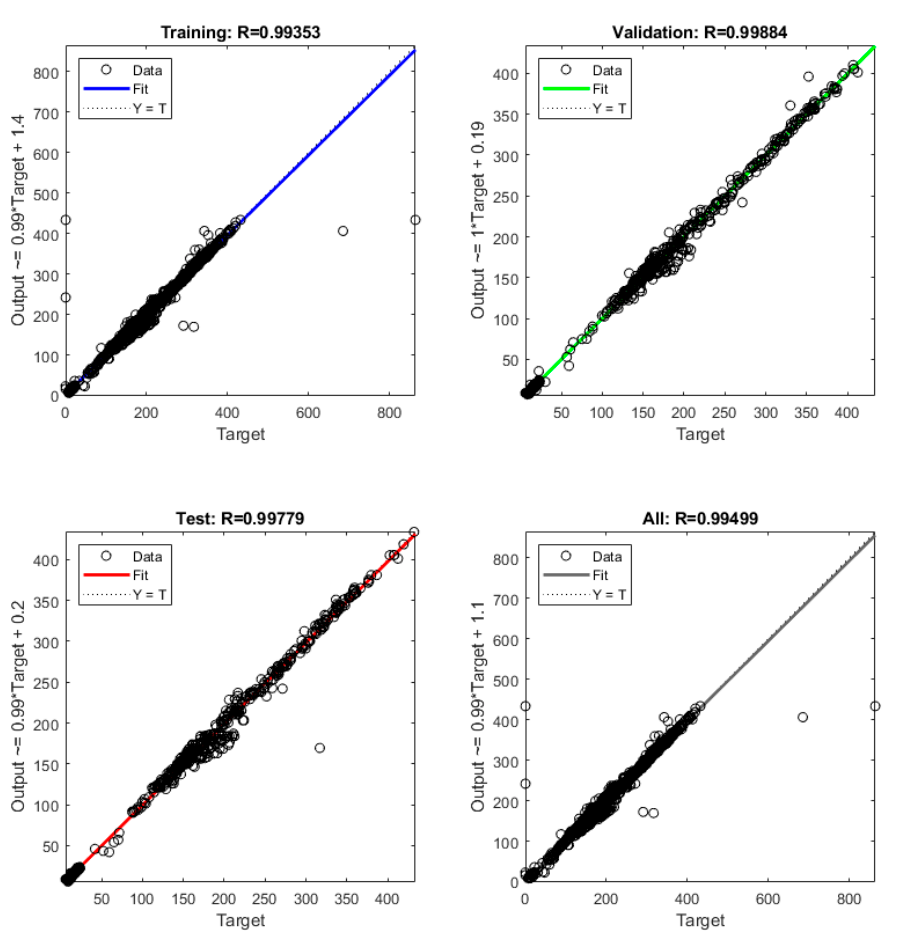
Figure 7. Regression distribution of neural network training.